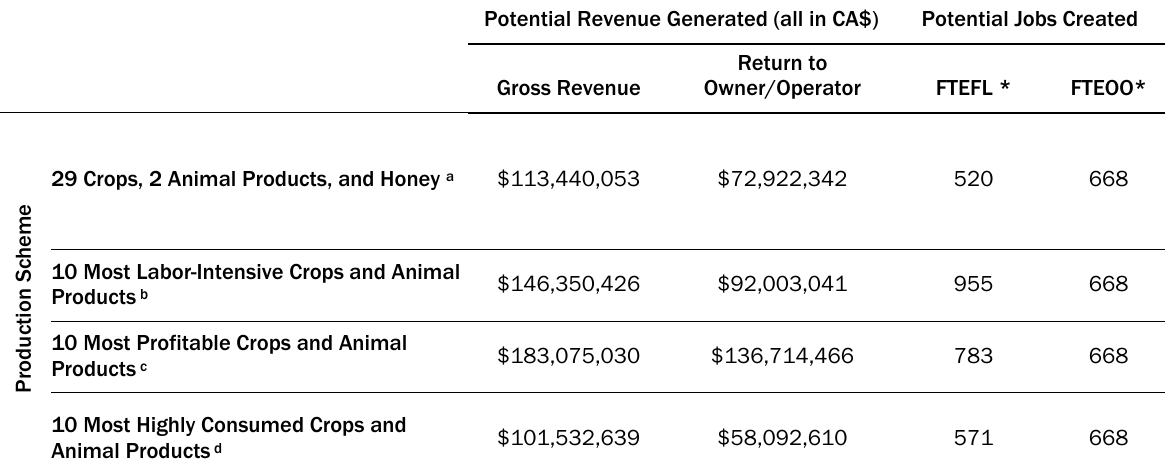
Table 5. Economic and Job Creation Potential of 1351 ha (279 acres) of Underutilized ALR land in